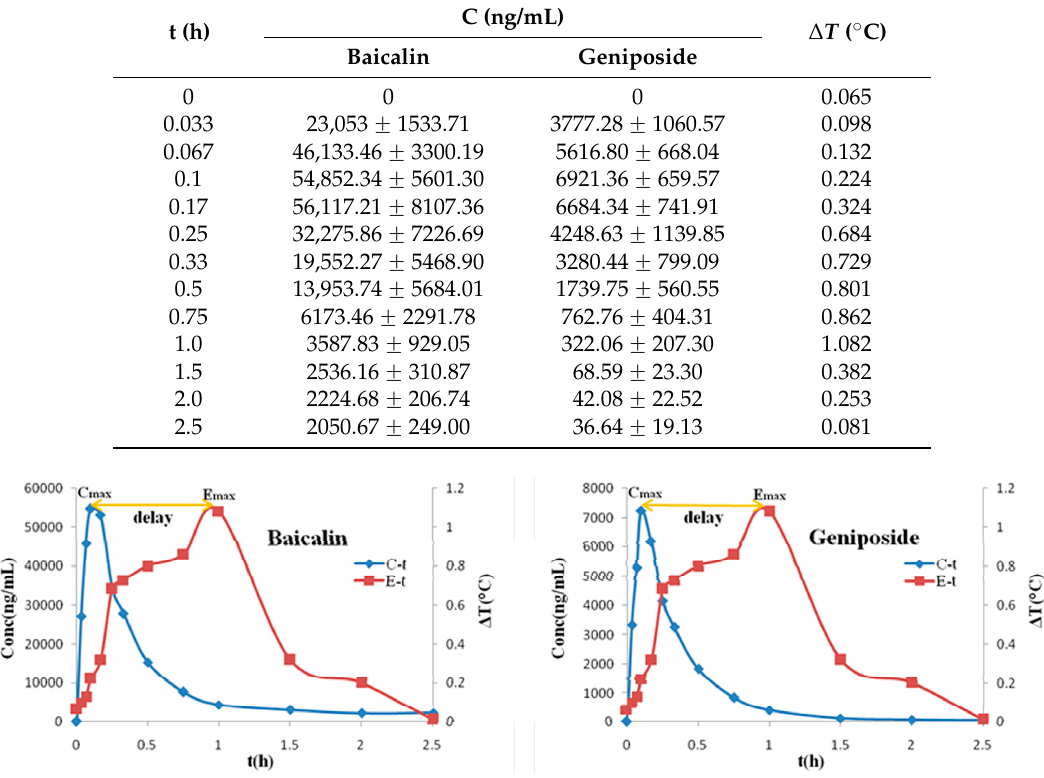
Figure 3. The peak effect lags behind the peak concentration of baicalin and geniposide after intraperitoneal administration of QKLI. ∆ T is the absolute value of the change in rectal temperature from MCG and MTG.